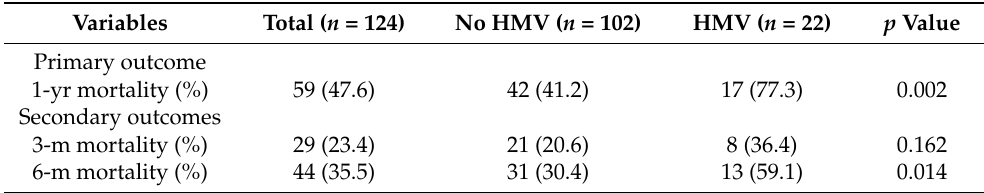
Table 2. Patient outcomes.